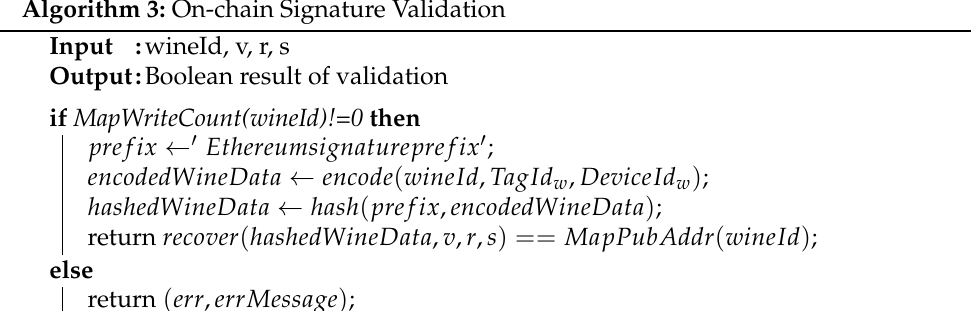
Algorithm 3: On-chain Signature